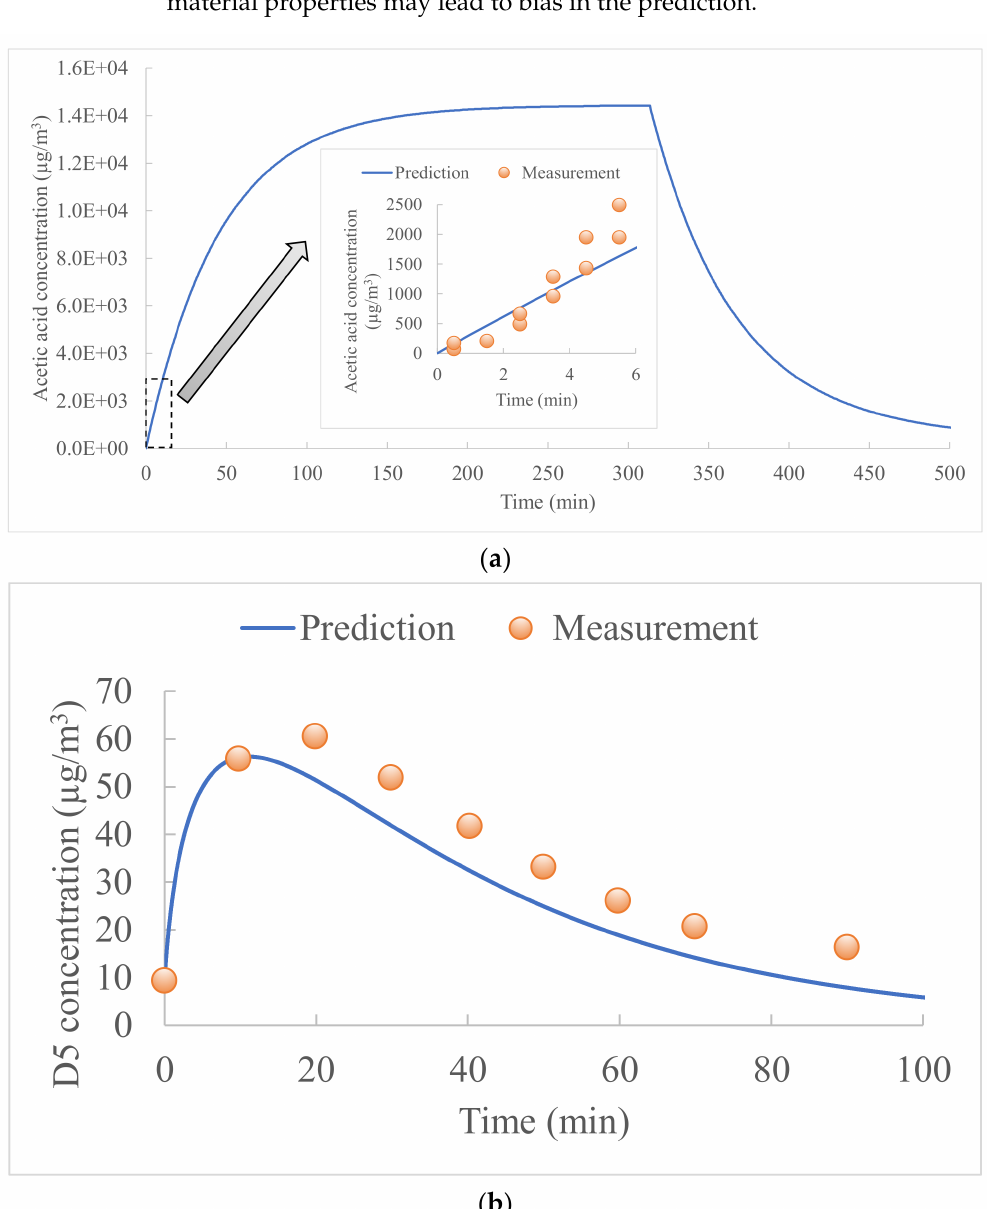
Figure 2. Indoor gas-phase concentrations of ( a ) acetic acid and ( b ) decamethylcyclopentasiloxane